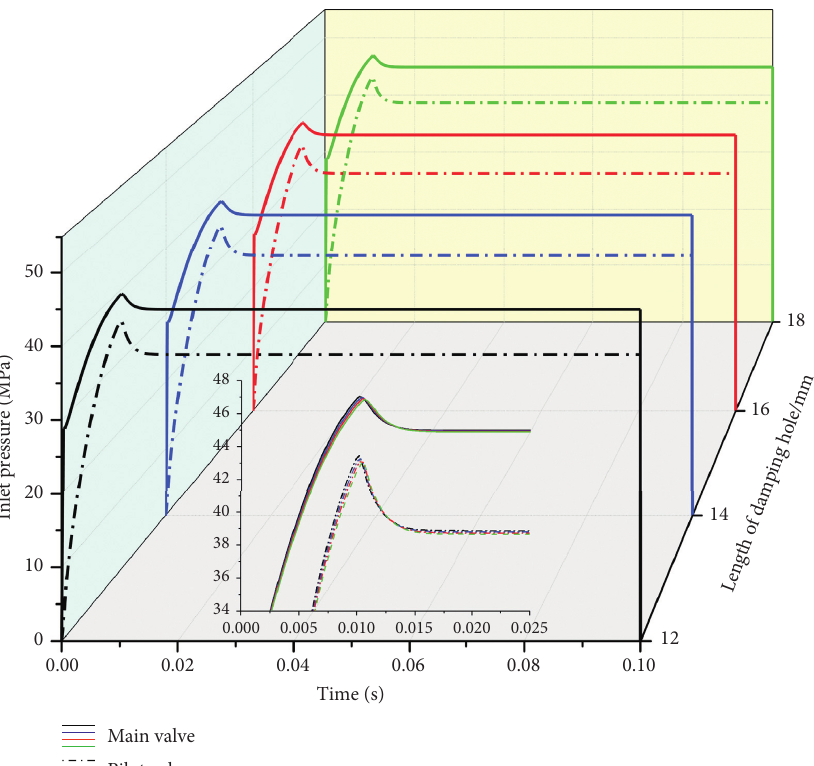
Figure 18: Influence of damping holes length.